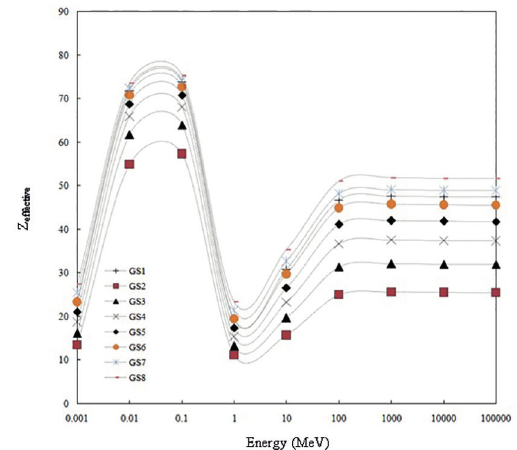
Figure 2: Plot of Effective atomic number for the prepared glass samples as a function of photon energy.